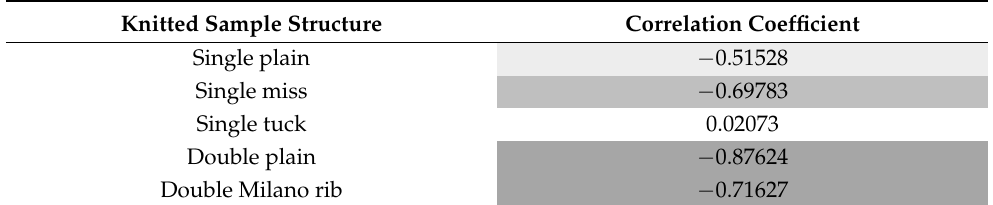
Table 11. Correlation coefficient of air permeability and heat resistance for different structures.